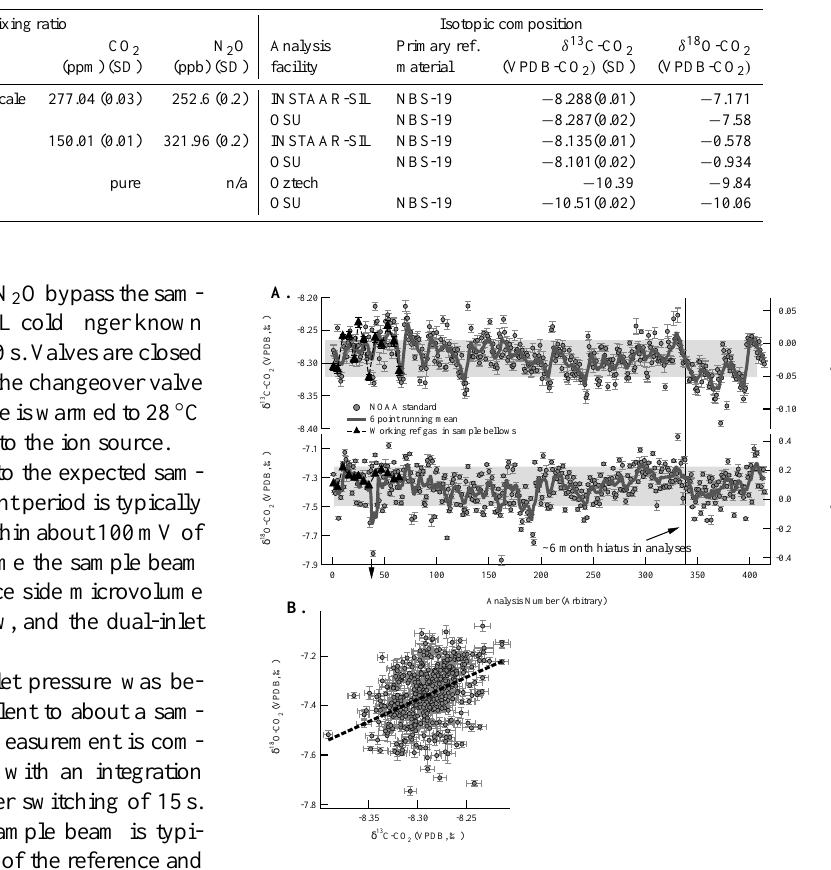
Figure 2. Standard measurement reproducibility: (a) all measure- ments of the NOAA1 standard gas over the course of a number of measurement campaigns encompassing about 5 months’ time in total. The δ 13 C and δ 18 O-CO 2 values are reported relative to the working reference gas. Black triangles represent analyses of the working reference gas stored in the sample bellows (plotted on the “zero” axis). The grey bars represent the 1 σ standard deviation (SD) of the NOAA1 standard over the entire period. (b) δ 13 C-CO 2 co- variation with δ 18 O-CO 2 ( R 2 =